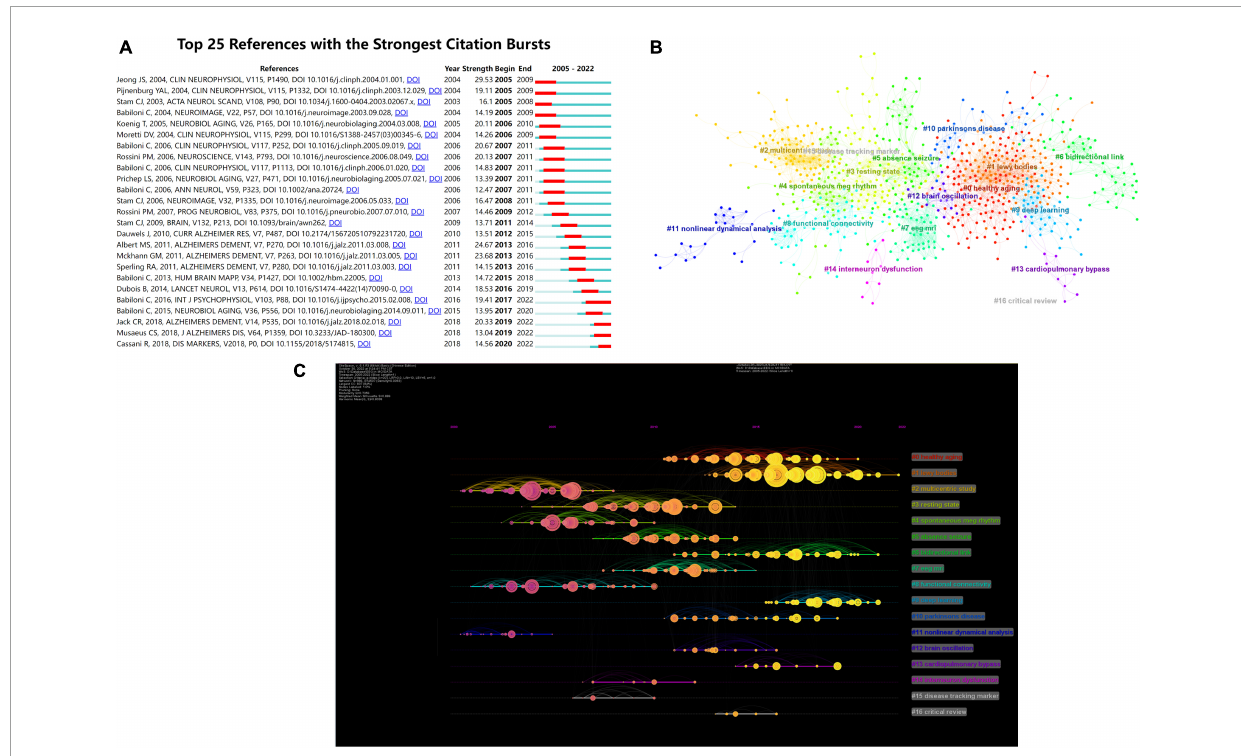
FIGURE6 (A) Top 25 references with strongest citation bursts. Blue lines represent time lines, while red sections represent specific time periods of citation bursts. (B) Cluster analysis of co-cited references on EEG for MCI. Different colors represent different clusters. (C) Time evolution analysis for co-cited references. The node at the start of the horizontal axis indicates when the reference first appeared. The more yellow color means the closer to 2022, and the more pink color means the closer to 2005. The size of nodes is proportional to the number of citations of the reference. Lines between nodes indicate co-cited relationships.